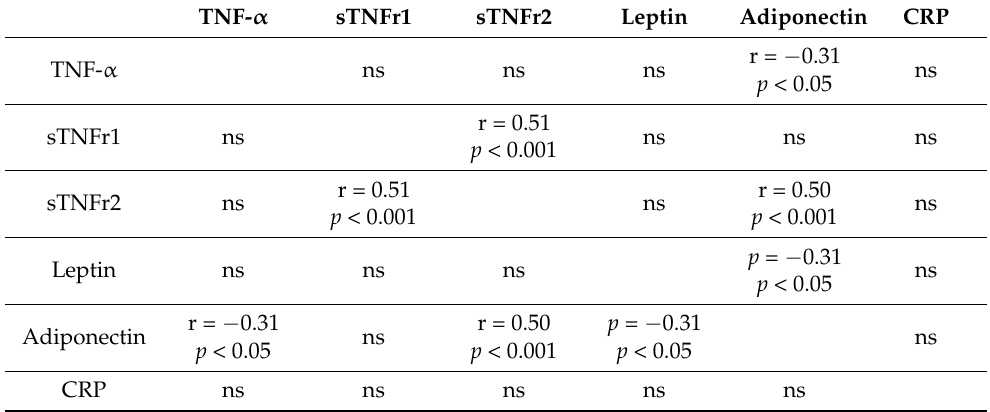
Table 4. Correlations between BMI, TNF activity and adipokines in overweight patients.